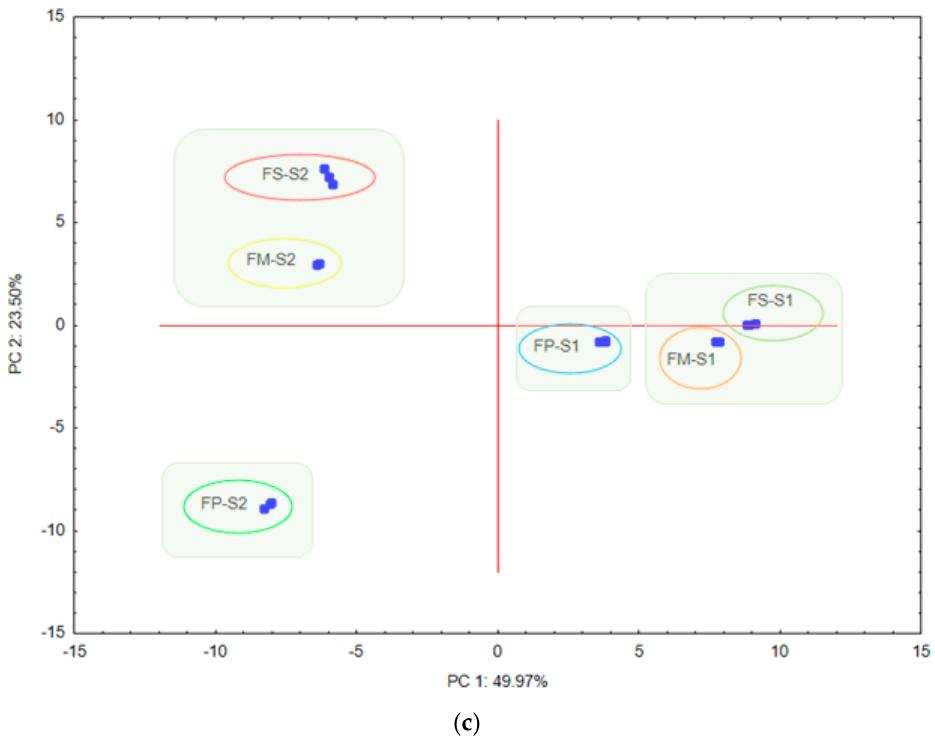
Figure 3. A comparison of the principal components (PC) plots generated with the results of relative abundances and area of peaks of different t-RFLP approaches (single, pooling and multiplex) for S1 and S2 within ( a ) bacterial, ( b ) archaeal and ( c ) fungal communities. Explanations: BS, bacterial single approach; BP, bacterial pooling approach; BM, bacterial multiplex approach; AS, archaeal single approach; AP, archaeal pooling approach; AM, archaeal multiplex approach; FS, fungal single approach; FP, fungal pooling approach; FM, fungal multiplex approach; S1, soil classified as Brunic Arenosol; S2, soil classified as Abruptic Luvisol.